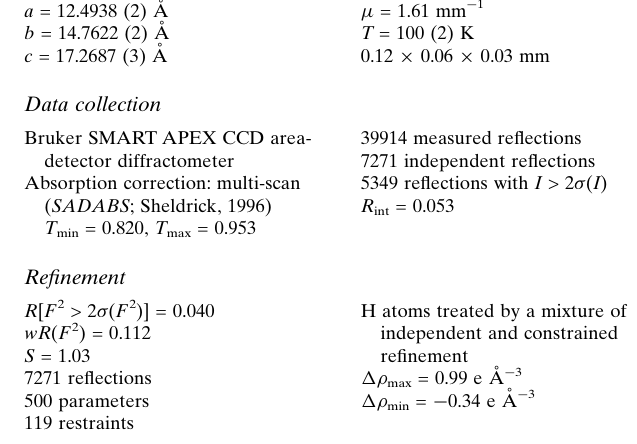
Bruker SMART APEX CCD area- detector diffractometer